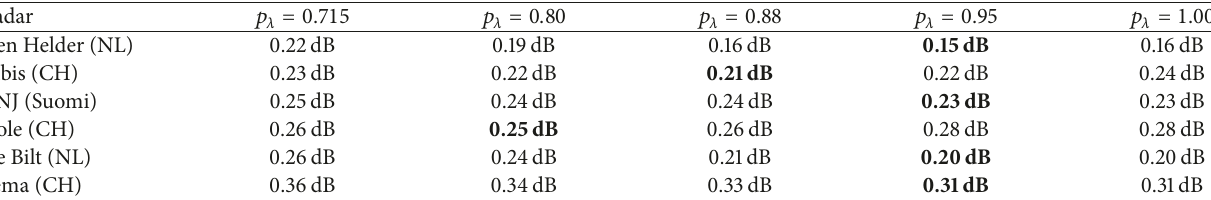
Table 4: Agreement in terms of scatter in dB between six radars in Europe and the DRAO reference in 2014 as a function of value of the angular coefficient 𝑝 𝜆 in